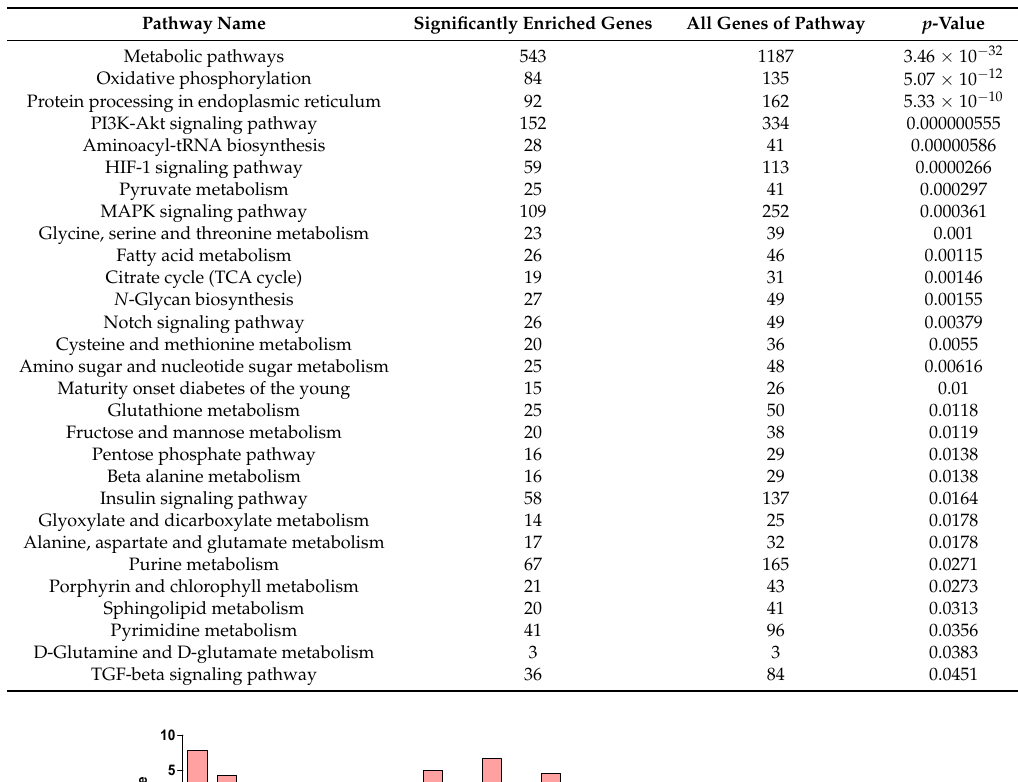
Table A1. Significantly changed genes enriched in different Kyoto Encyclopedia of Genes and Genomes (KEGG) pathways (represented by p -values) in progenitor-like cells cultured in vitro compared to pancreatic single cells.